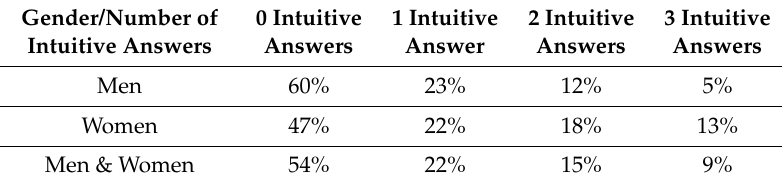
Table A11. Distribution of Number of Intuitive Answers on the CRT by Gender. Gender/Number of